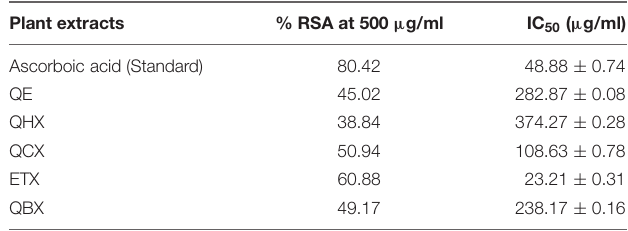
TABLE 2 | NO scavenging activity of Querus incana Roxb.